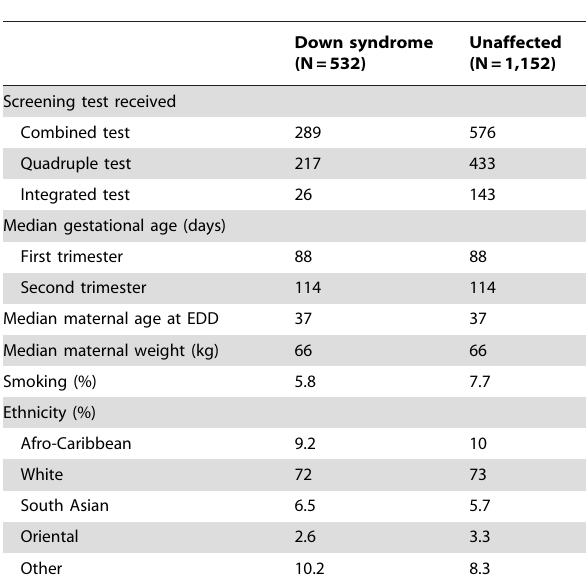
Table 1. Number of pregnancies classified according to screening test, gestational age when screened, and selected characteristics of the Down syndrome and unaffected